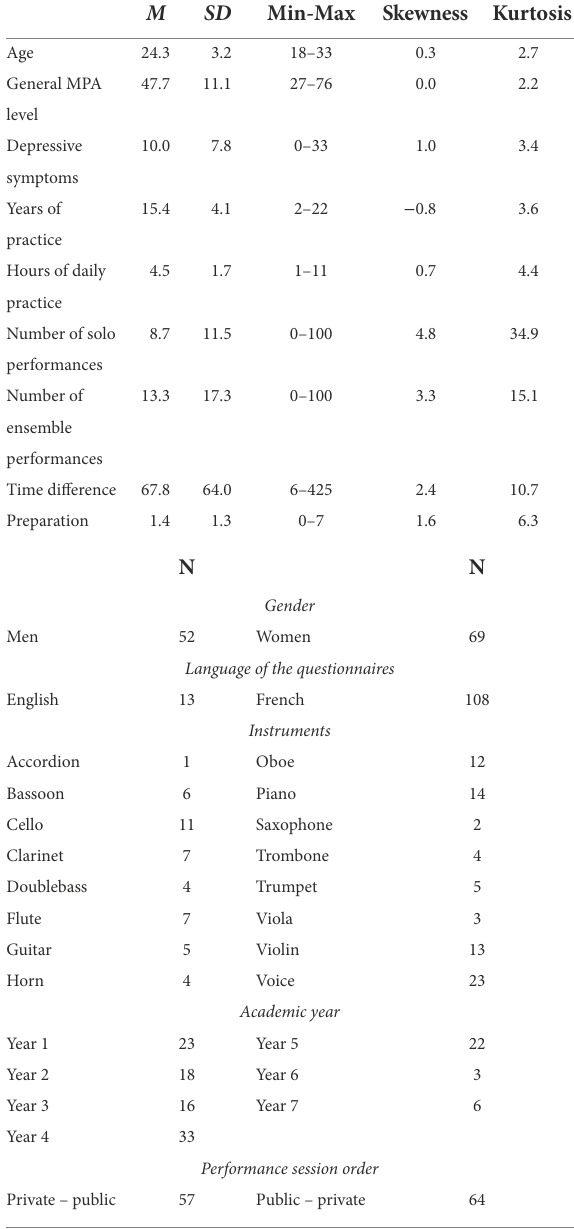
TABLE 1 Sample and predictors descriptive